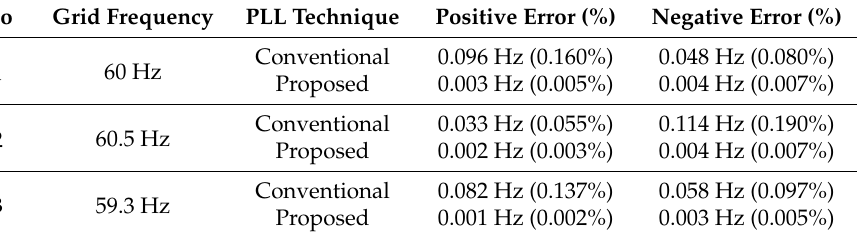
Table 2. Measurement error using two different PLL techniques.